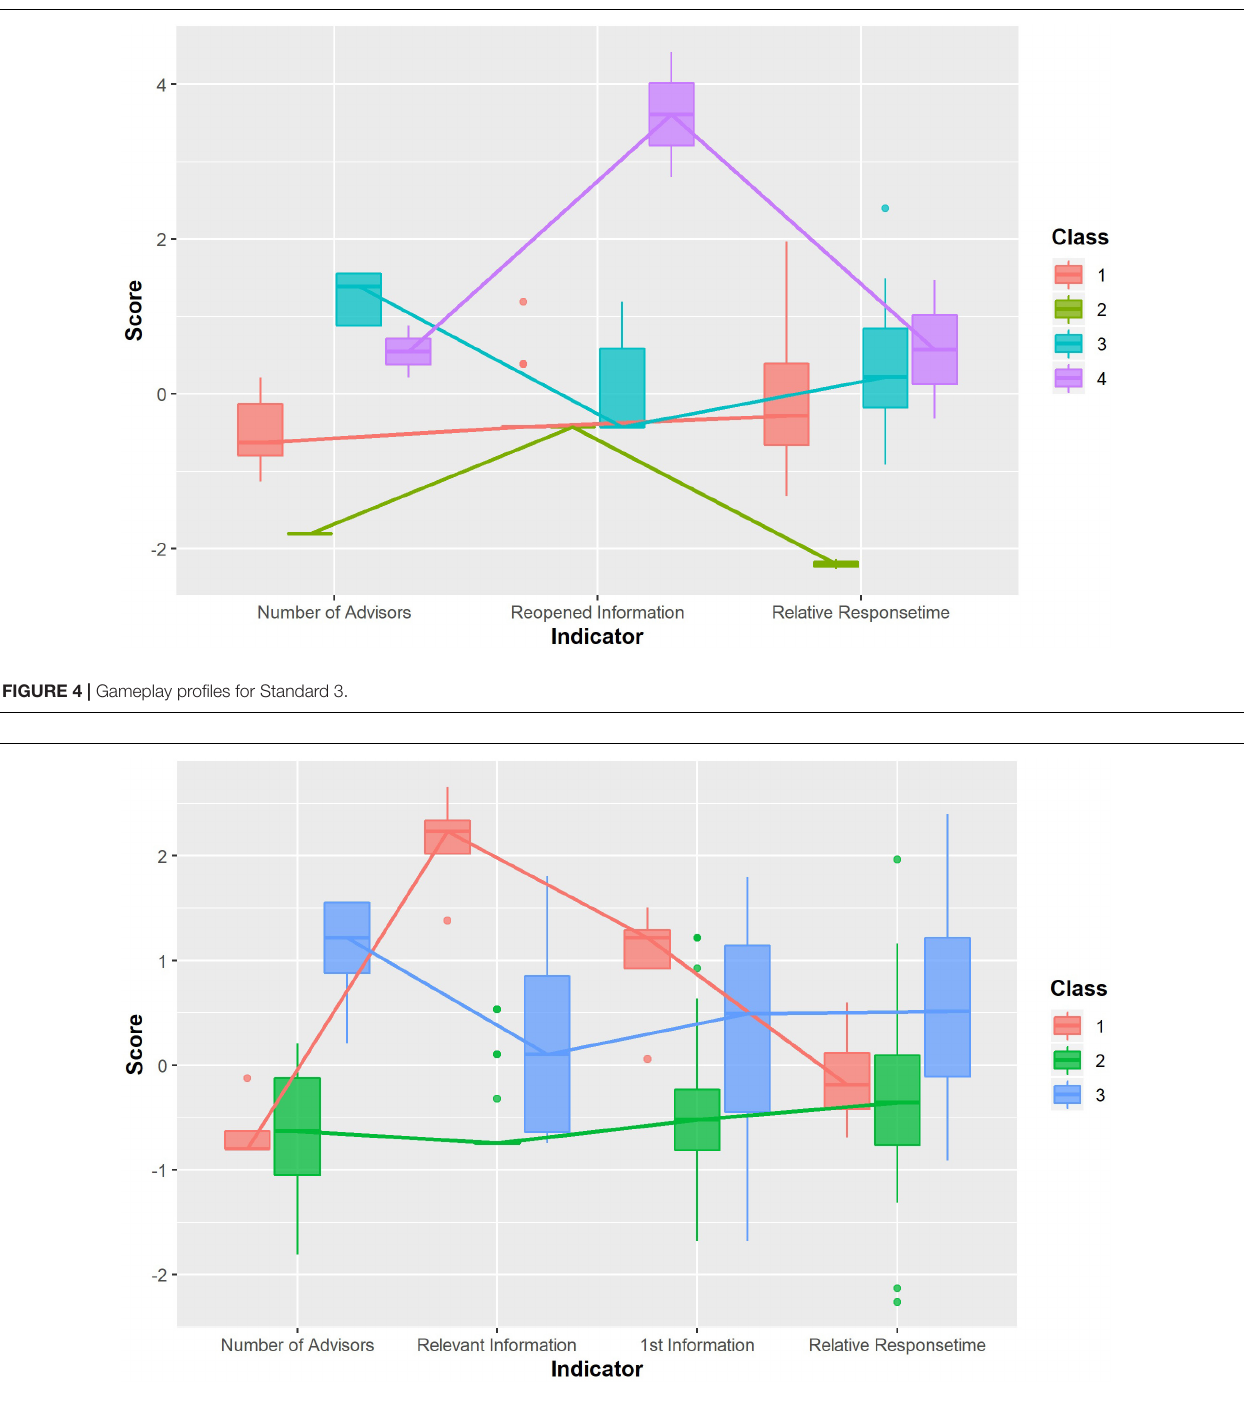
FIGURE 5 | Gameplay profiles for Standard